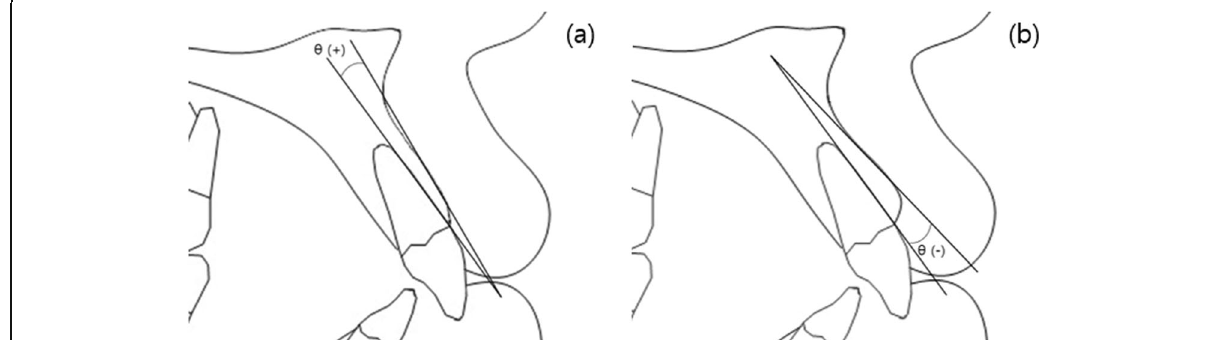
Fig. 5 Measured angle ( a , b ) between the incisor and surrounding bone. a , b The angle between the line touching the margin of the tooth at the alveolar crest level and the line touching the marginal margin of the alveolar